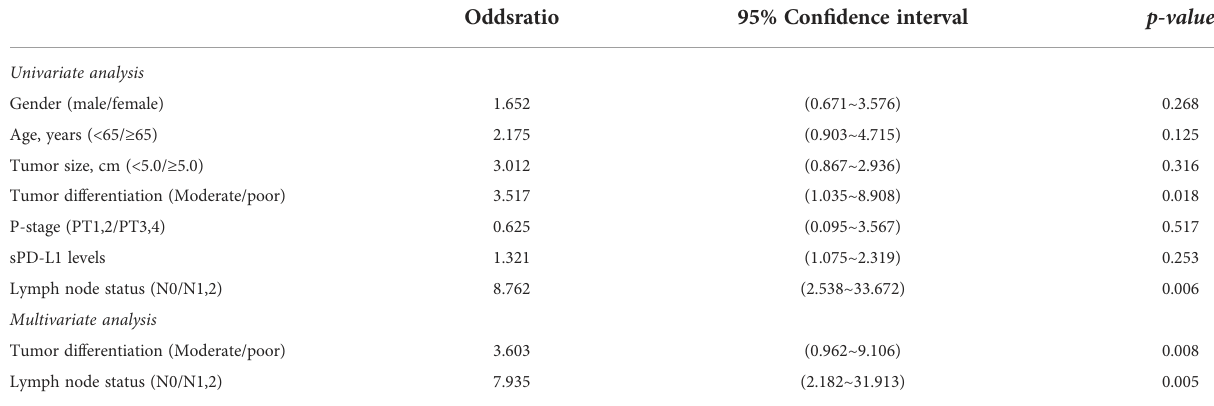
TABLE 3 Prognosis analysis (Cox proportional hazards